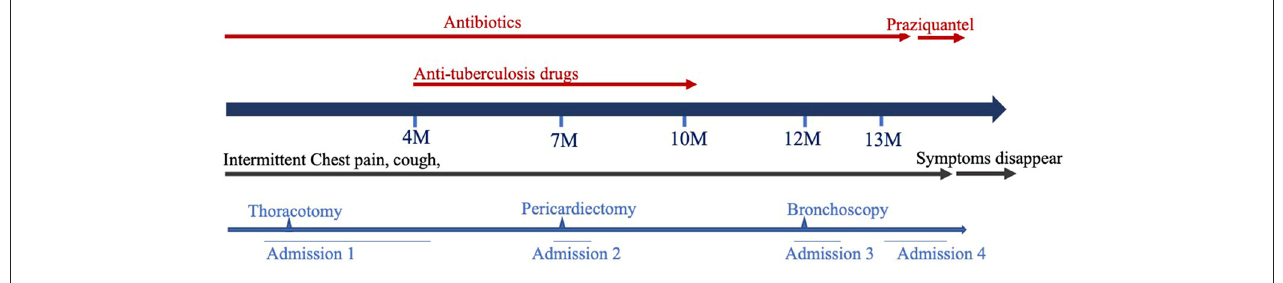
FIGURE 2 | Diagrammatic representation of the symptoms and